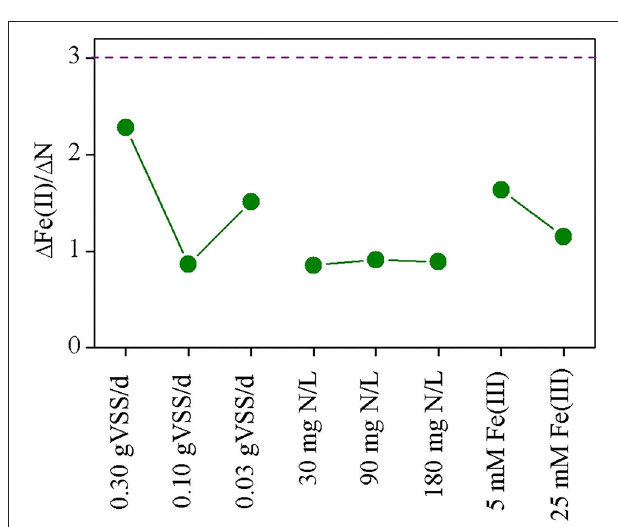
FIGURE 7 | Molar ratio of Fe(II) produced to ammonium removed in the batch